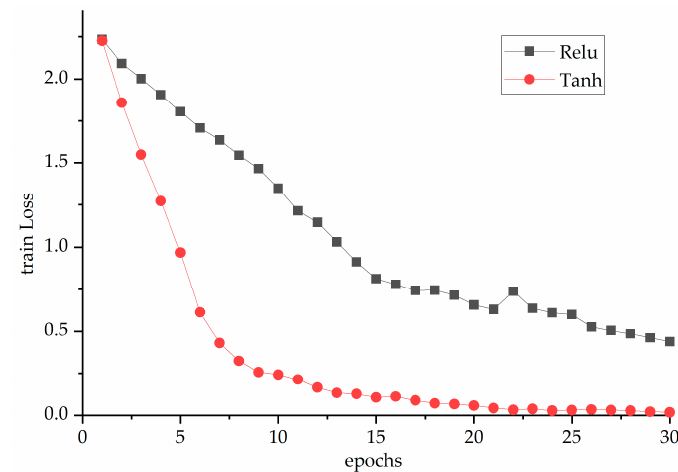
Figure 7. Loss function during the training set with Tanh and Relu.